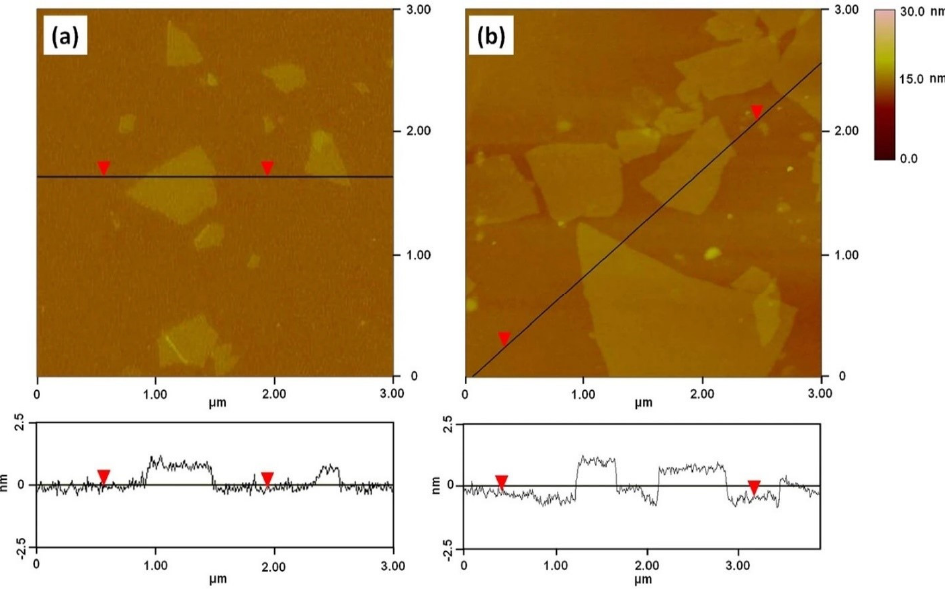
Figure 8. Atomic force microscopy (AFM) images and cross-sectional analysis of ( a ) GO and ( b ) S-rGO [161] (CC BY).